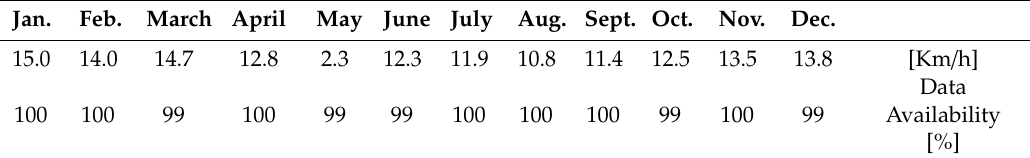
Table 3. Wind-force per Day (January 2000–December 2018).